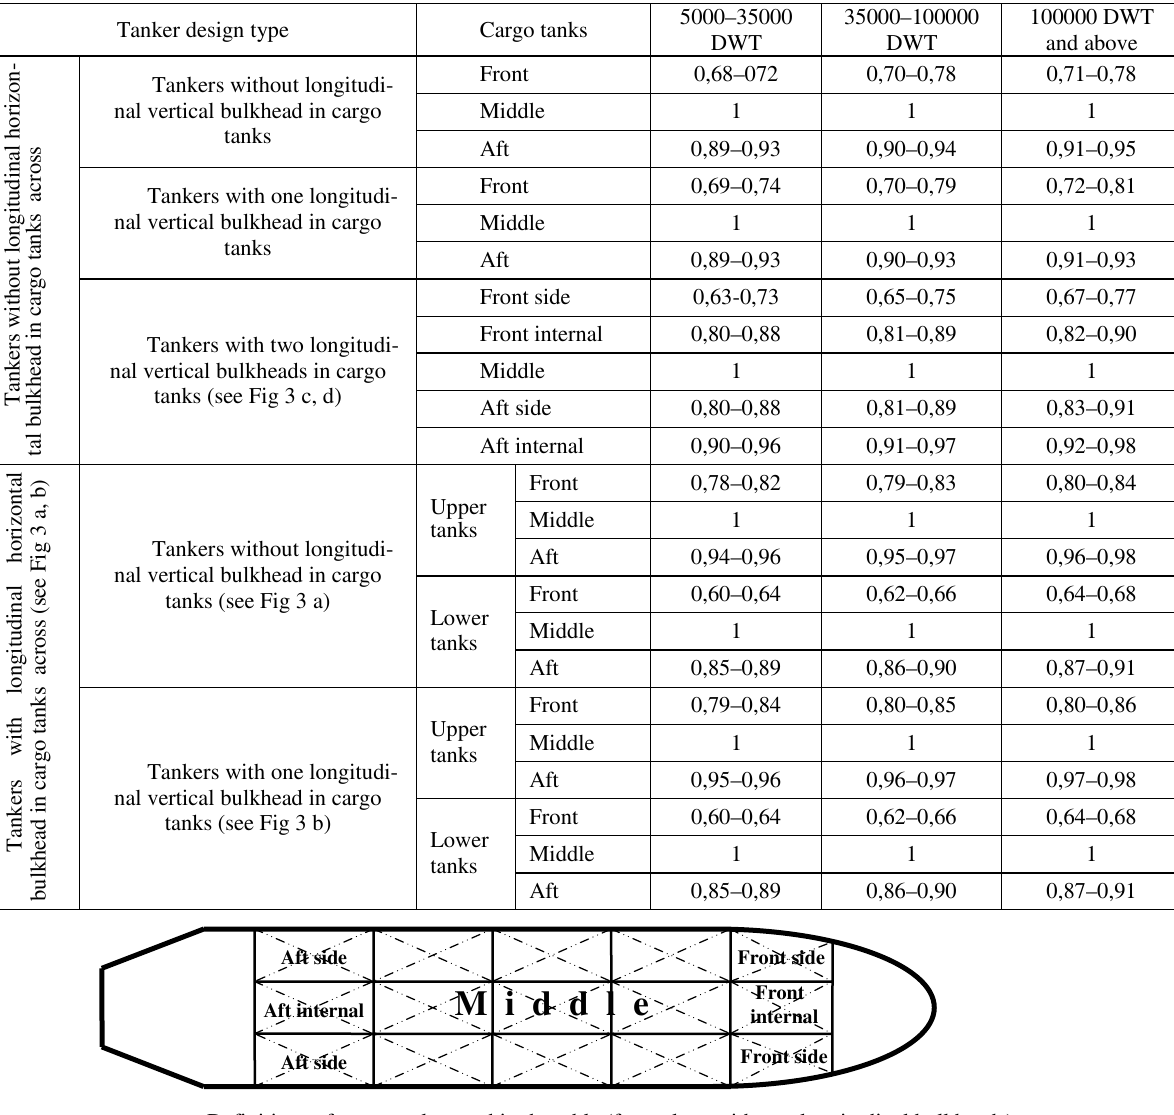
Table 3. Volumetric coefficients for tankers of different design types Tanker design